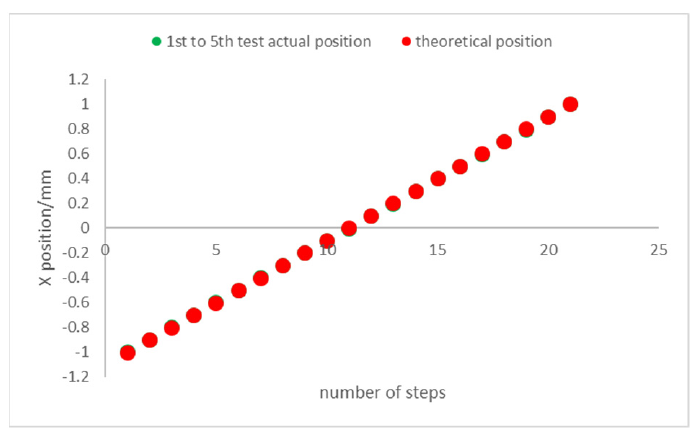
Figure 13. Measurement results of the z-directional position accuracy of the SMAM. The absolute positioning error of the measurements after each step of the movement compared to the theoretical position is analyzed, as shown in Figure 14